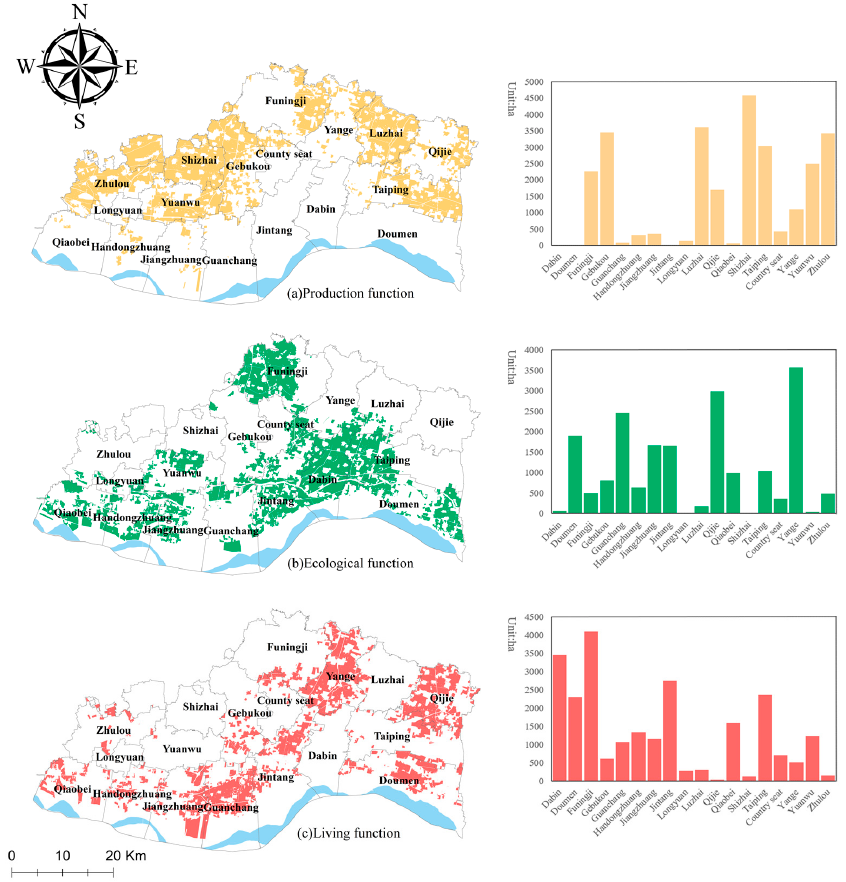
Figure 5. Spatial distribution of the leading CLUFs in Yuanyang County; ( a – c ) represent production function, ecological function, and living function, respectively.